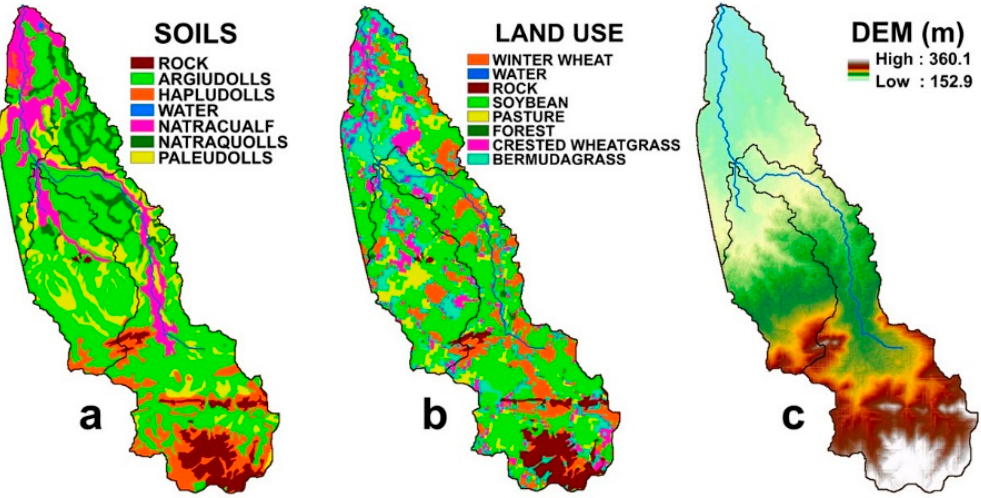
Figure 7. Santa Catalina stream basin maps: ( a ) soil types; ( b ) land uses; and ( c ) digital elevation model (DEM).